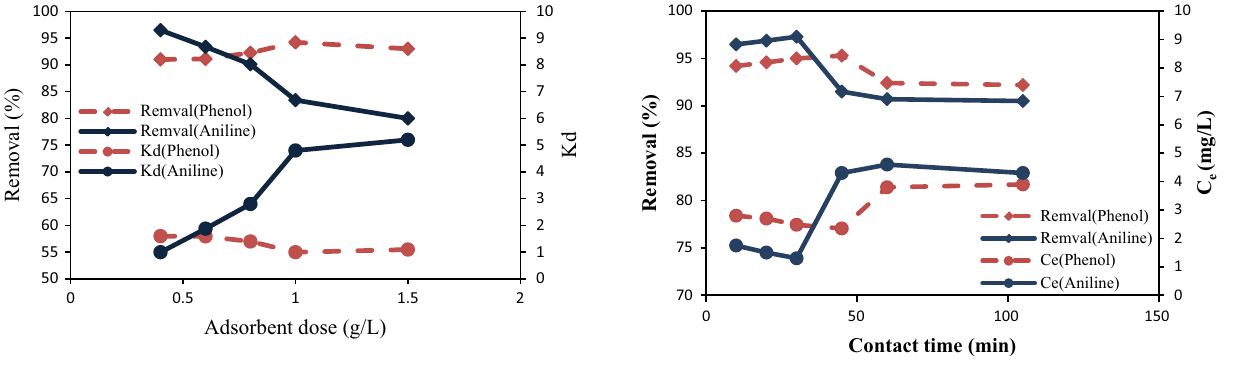
Fig. 4 Effect of adsorbent dose on removal efficiency of pollutants by bentonite (contact time = 60 min, pH = 6, pollutants concentra- tion = 50 mg/L) Table 4 Effect of adsorbent dose on aniline and phenol removal by